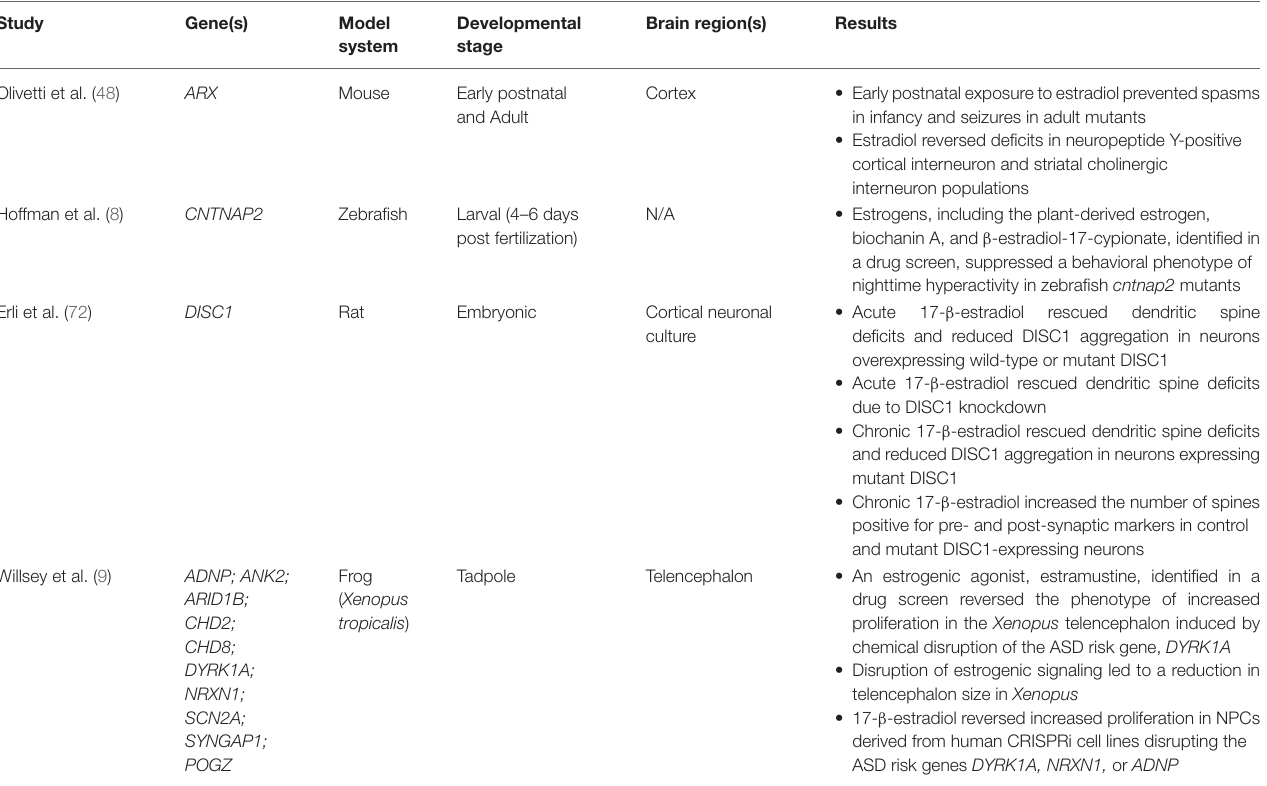
TABLE 2 | Preclinical studies of estrogens in genetic models of ASD and other neurodevelopmental disorders. Study